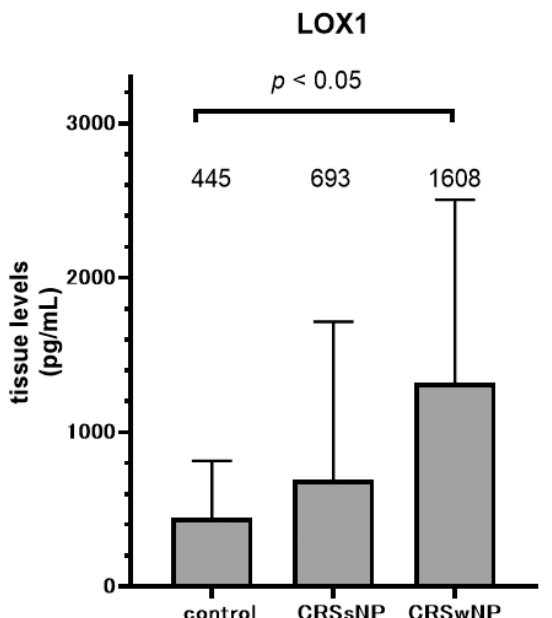
Figure 3. Comparison of tissue levels of LOX-1 protein in paranasal sinus mucosa from controls and CRSsNP and CRSwNP patients as detected by ELISA. Data are mean ± SD.